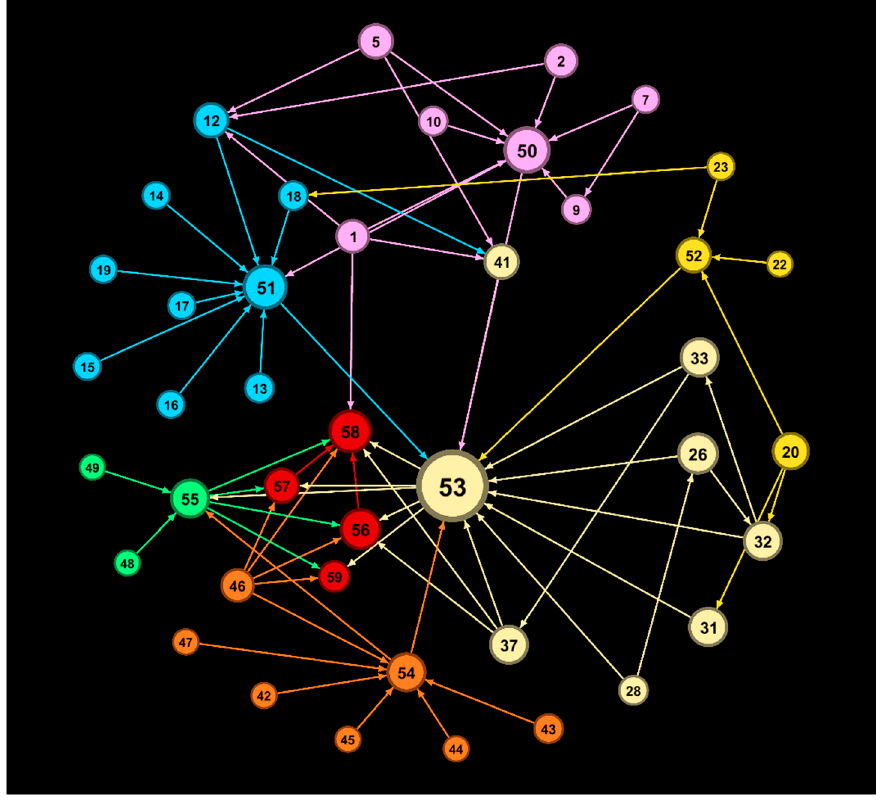
Figure 7. NQPB after 17 key nodes were